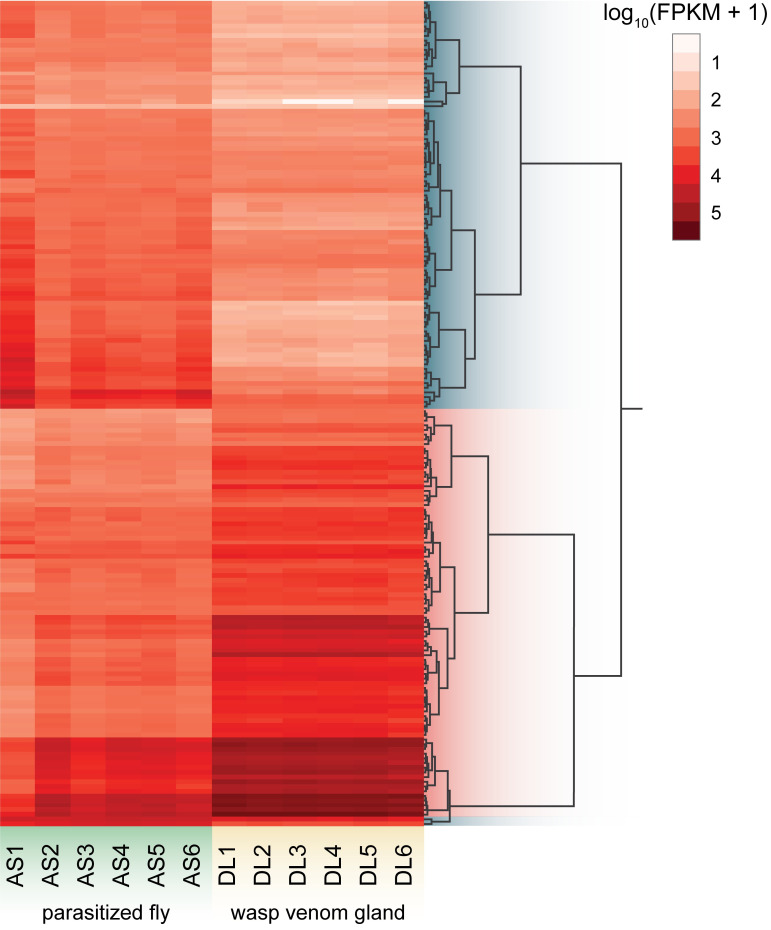
DlEPV shows widespread differential expression during replication in D. longicaudata wasps compared to A. suspensa flies.Heatmap showing significantly (FDR q < 0.05) differentially expressed DlEPV genes in wasp and fly tissue. Each row represents a DlEPV gene, and each column represents that gene’s expression in each of the 12 RNA samples. Expression is depicted as the log10 transformed FPKM value. Columns AS1-6 correspond to the 6 parasitized fly RNA replicates, and DL1-6 correspond to the 6 wasp venom gland replicates. Rows were clustered using the Ward method based on similarity in gene expression pattern across the 12 samples: DlEPV genes that were significantly downregulated in wasp tissue are highlighted in blue, and genes that were significantly upregulated in wasp tissue are highlighted in pink.